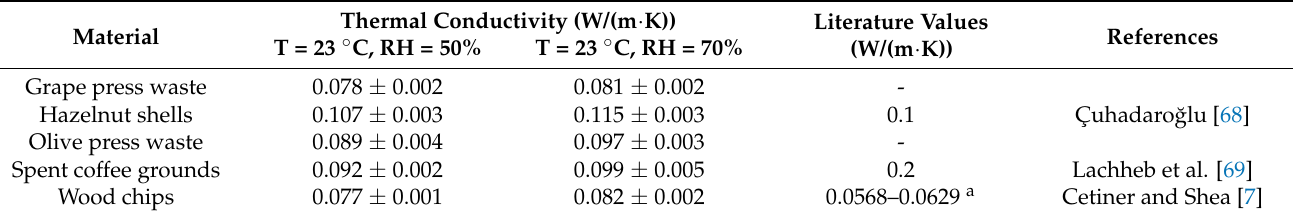
Table 5. Thermal conductivity of the analysed bio-wastes and comparison with literature